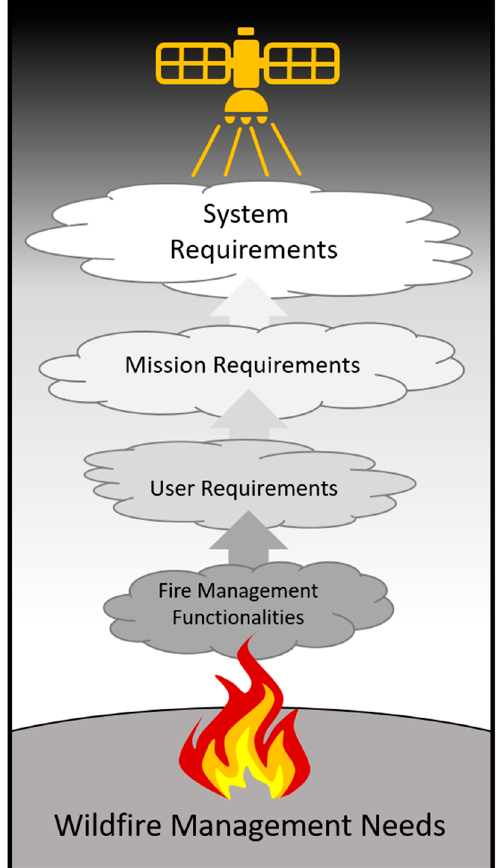
Figure 4. Illustration of the process of defining satellite system requirements based on wildfire management needs in Phase-A of the WildFireSat mission. Fire Management Functionalities (FMFs) are defined qualitatively to capture the Wildfire Management Needs without consideration of space system capabilities or limitations. The FMFs are then translated into User Requirements, which take into consideration space system capabilities required to deliver the necessary data, but do not target any specific mission configuration or scenario. The Mission Requirements define a specific mission scope to address the User Requirements under a specific funding envelope. The Mission Requirements are then used to produce detailed System Requirements describing the technical design of the satellite system. At each level of refinement, the original source of each requirement can be traced back to the end-user’s needs thereby ensuring that the technical design of the satellite system is fundamentally driven by the Wildfire Management Needs.